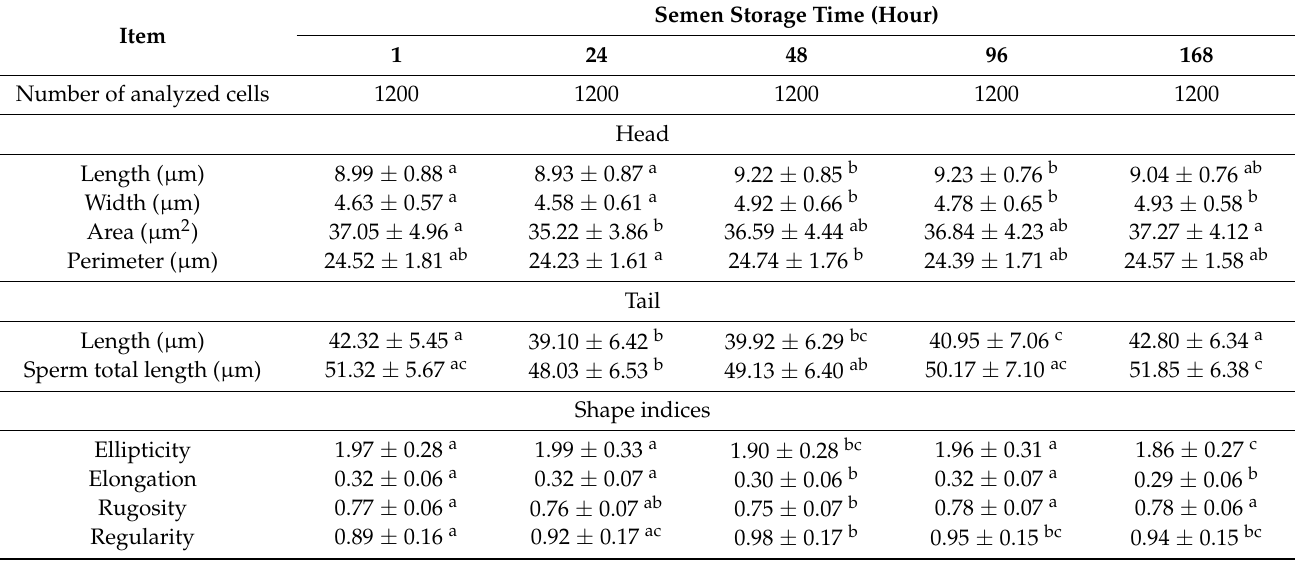
Table 1. Morphometric dimensions of sperm stained by the eosin-nigrosin method in semen stored at 17 ◦ C (mean ±